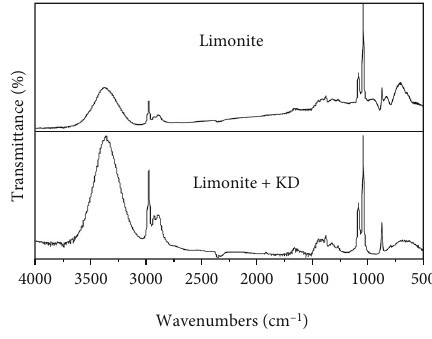
Figure 19: FTIR spectra of limonite and KD.